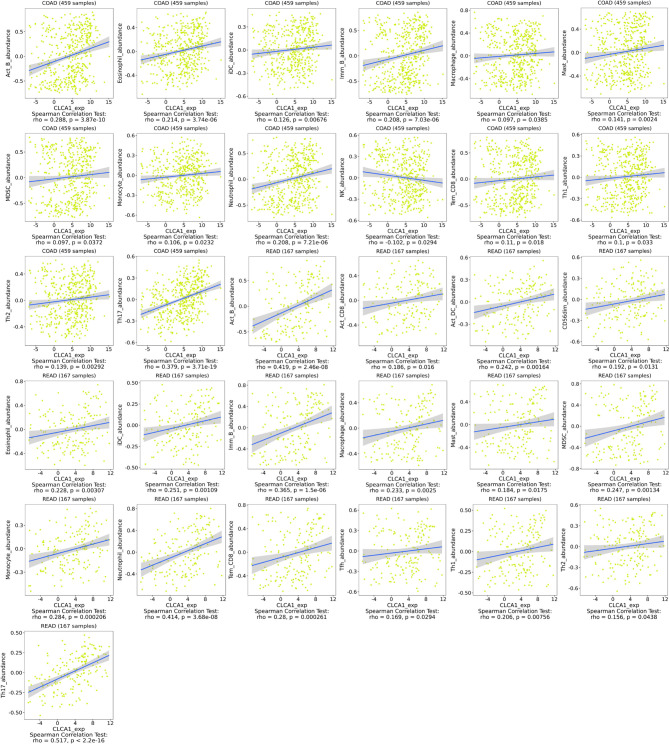
Relationship with immune infiltration. CLCA1 in colon cancer and rectal cancer.